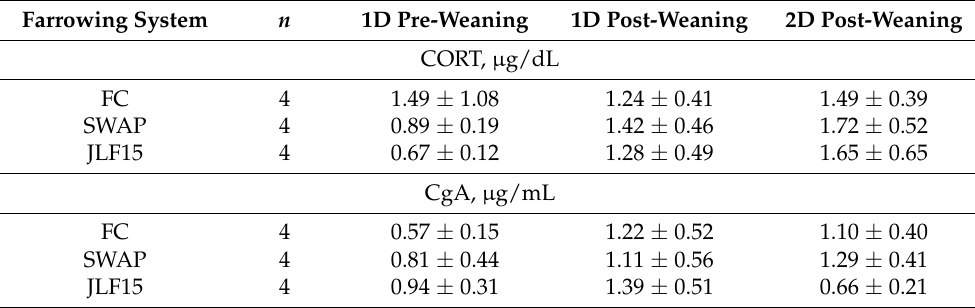
Table 8. Concentration of salivary cortisol (CORT) and chromogranin A (CgA) of sows (mean ± SE) collected on D23 (1D pre-weaning), D25 (1D post-weaning) and D26 (2D post-weaning) in three far- rowing systems (FC: conventional farrowing crate; SWAP and JLF15: farrowing pens with temporary crating). n indicates the number of group pens. Farrowing